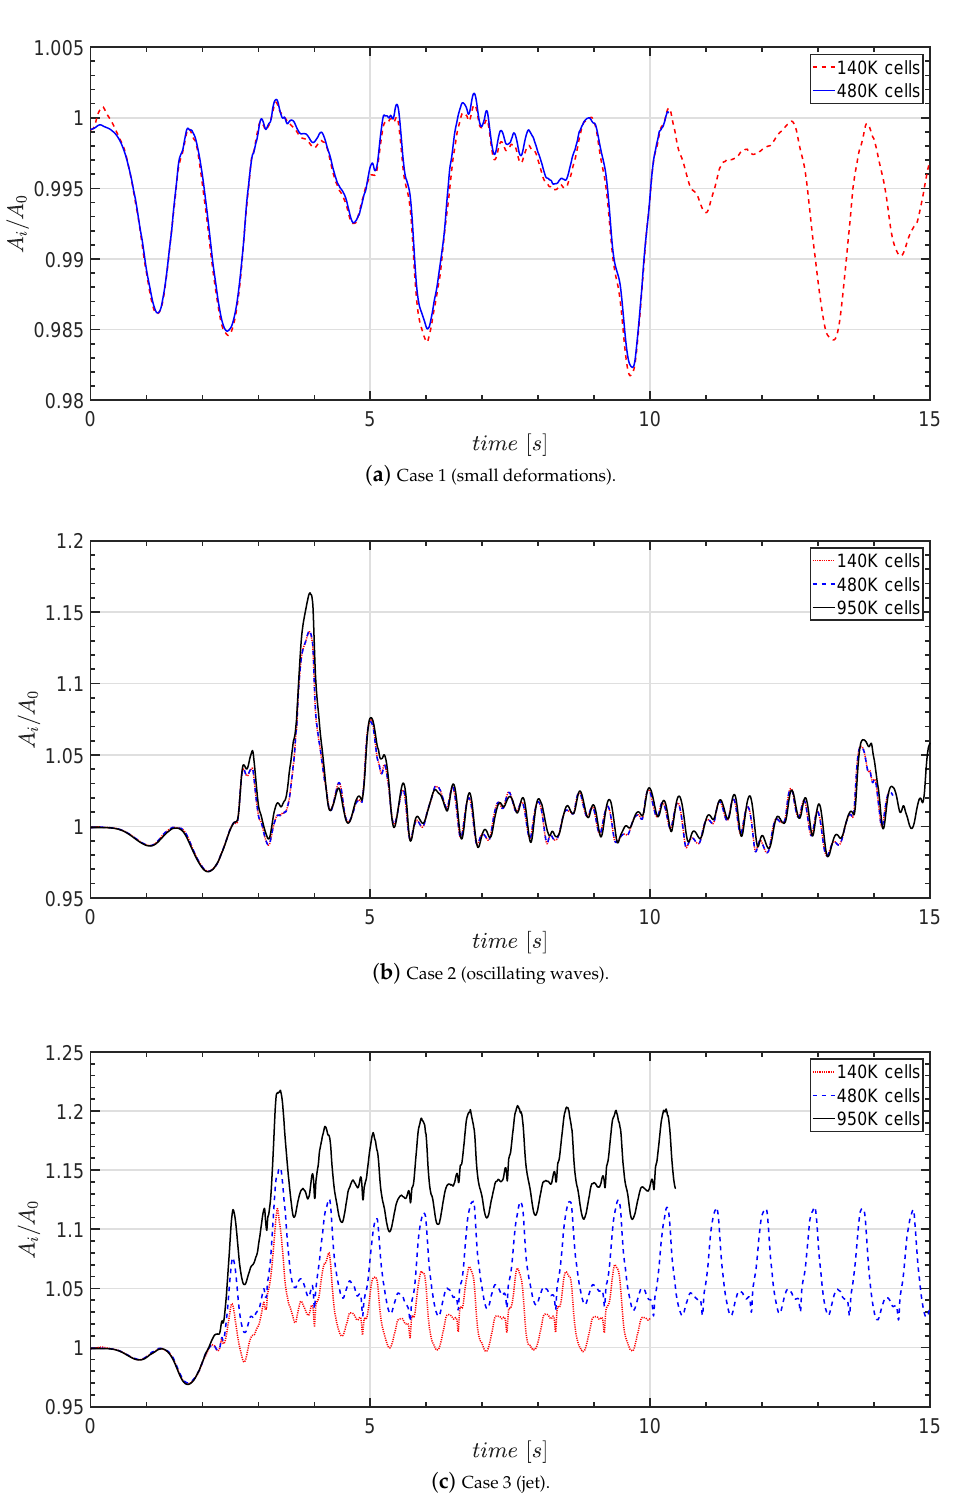
Figure 8. Simulated interface area, A i , divided by the undisturbed interface area, A 0 , with different